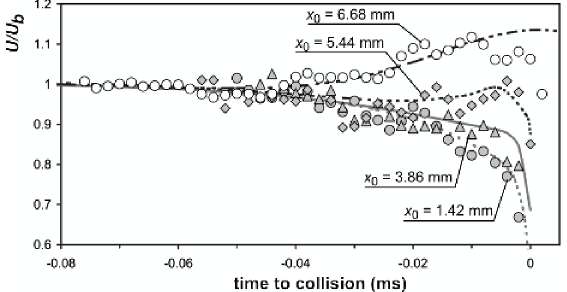
Fig. 4. Comparison of the bubble velocity computed using the full model and experimental